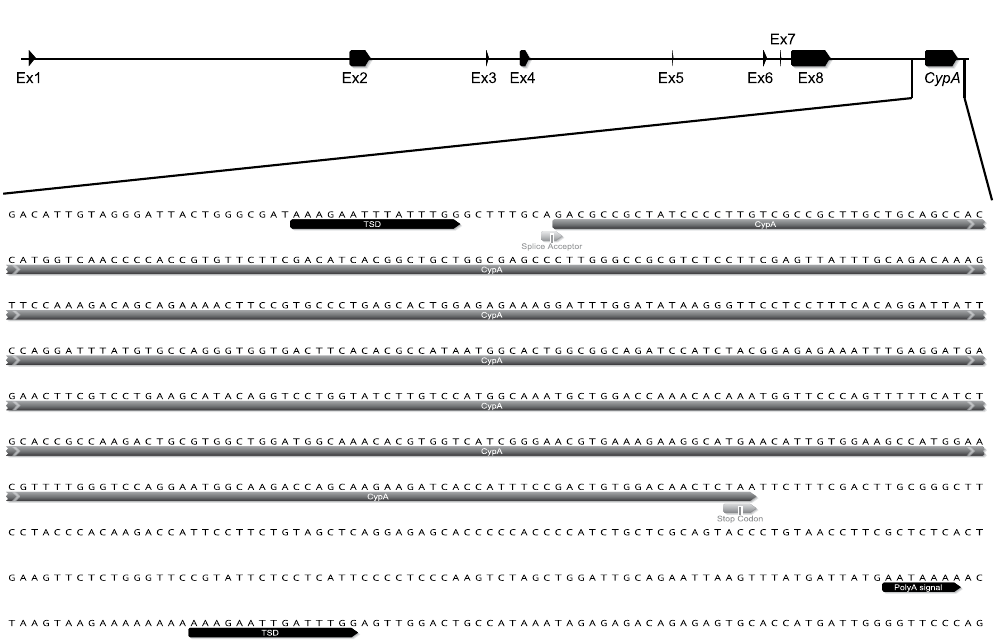
Figure 5. Retrotransposed CypA gene in the Trim5 cluster of P. maniculatus . (Upper panel) Schematic of the genomic organization of the P. maniculatus TrimCyp gene. (Lower panel) DNA sequence of the retrotransposed CypA gene in the Trim5 cluster of the P. maniculatus genome is shown with various features indicated. Figure was created using Geneious 43 . TSD; target site